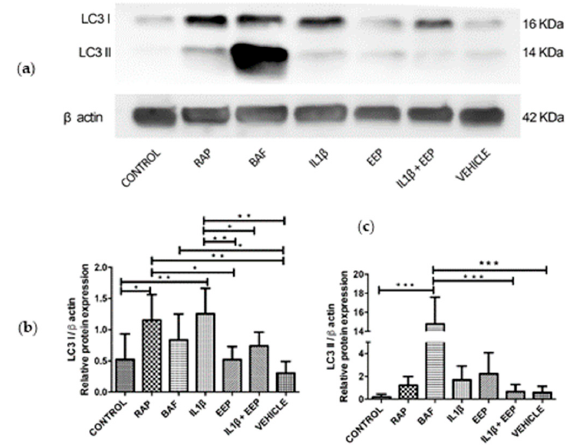
Figure 3. Effects of IL-1 β and EEP treatment on autophagy markers. ( a ) Relative expression of LC3 I